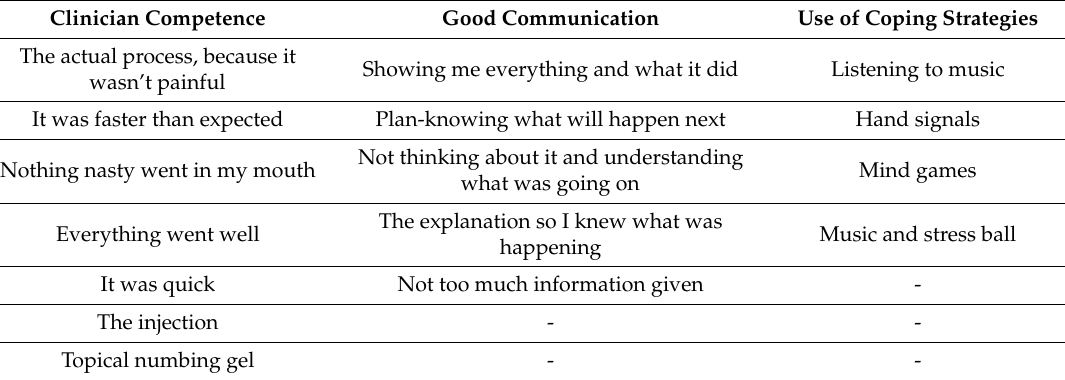
Table 4. Examples of things children said had worked best for them, following their dental visit, within three themes.